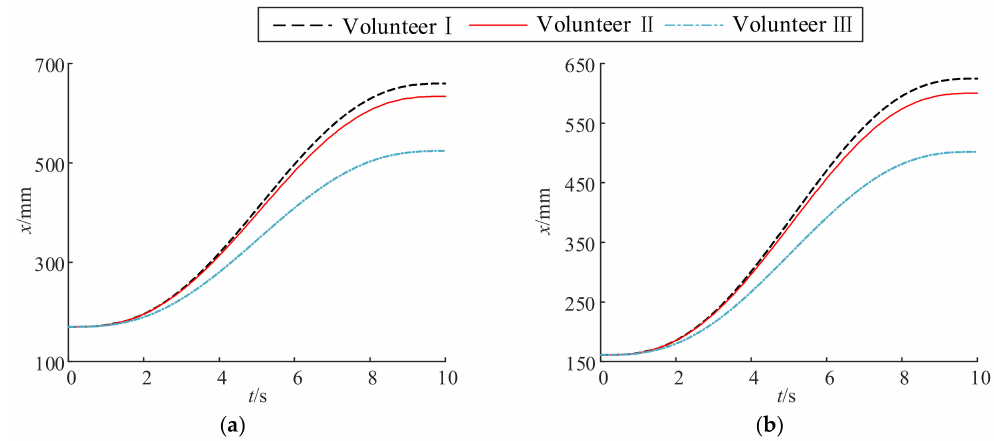
Figure 13. The value of x 1 and x 2 over time. ( a ) The terminal x 1 value varies with time. ( b ) The terminal x 2 value varies with